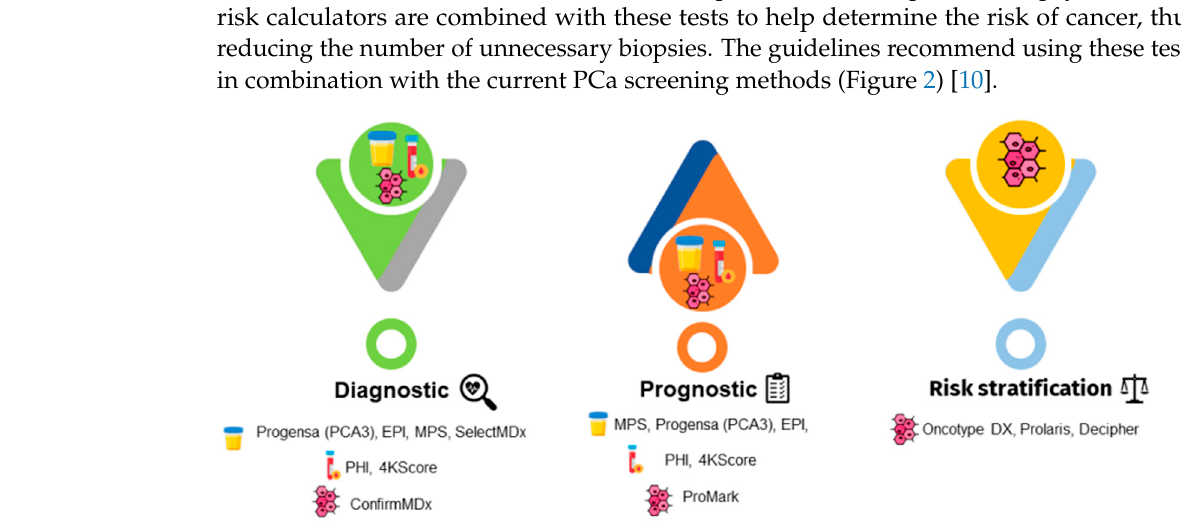
Figure 2. Emergent prostate cancer biomarkers for urine, serum, and tissue samples have been developed and can be used for diagnostic, prognostic, or risk stratification purposes. Legend: EPI, ExoDx Prostate IntelliScore; MPS, MyProstateScore; PCA3, prostate cancer gene 3; PHI, Prostate